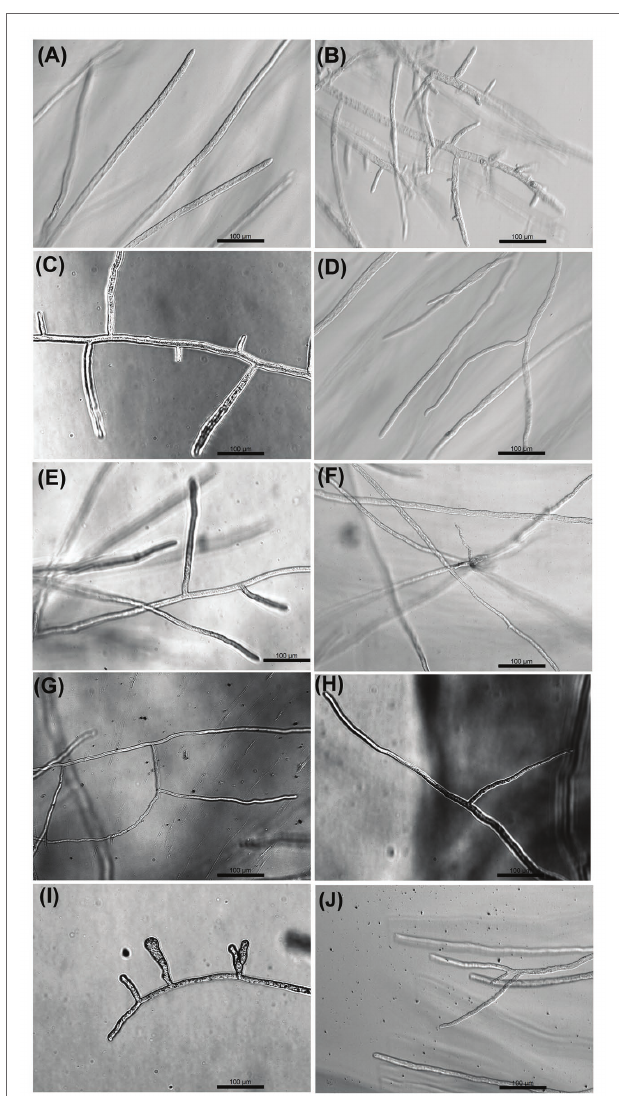
FIGURE 3 | Optical microscopy observation of the effect of selected compounds on the growth of hyphae of S. parasitica after 24 h culture at 24 ° C in Machlis medium. (A) No Drug, (B) Triclosan (4 μ g/ml), (C) Benzoic acid (400 μ g/ml), (D) Acetohydroxamic acid (600 μ g/ml), (E) Sulfamethoxazole (400 μ g/ml), (F) Chloramphenicol (800 μ g/ml), (G) Azelaic acid (800 μ g/ml), (H) Copper sulfate (200 μ g/ml), (I) Boric acid (400 μ g/ml), and (J) Malachite green (0.8 μ g/ml). Scale bars = 100 μ